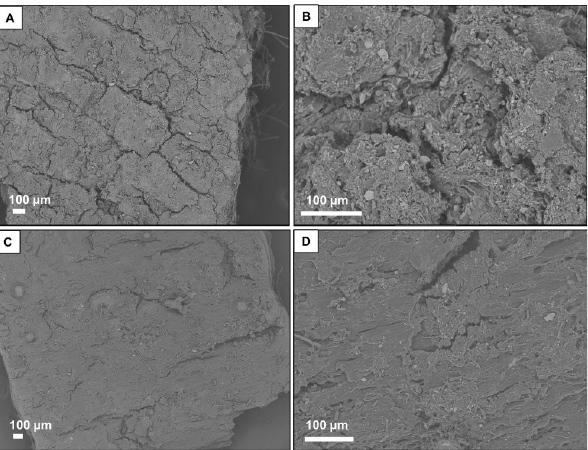
Fig 7. Back-scattered images of outer bark surface using by FE-EPMA. (A) (B) Zelkova serrata (Z1–B1). (C) (D) Cerasus sp.